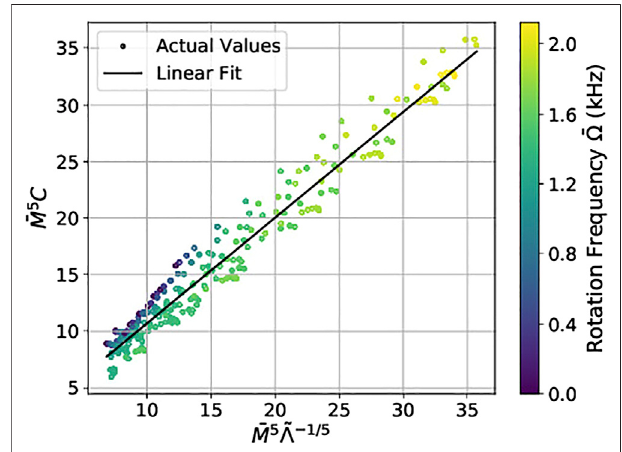
FIGURE 6 | The linear fi t between (cid:2) M 5 ~ Λ − 1/5 and (cid:2) M 5 C for q (cid:1) 1, considering only soft EoSs. The fi t corresponds to Eq. 16 . Figure taken from Manoharan et al. (2021) with permission by